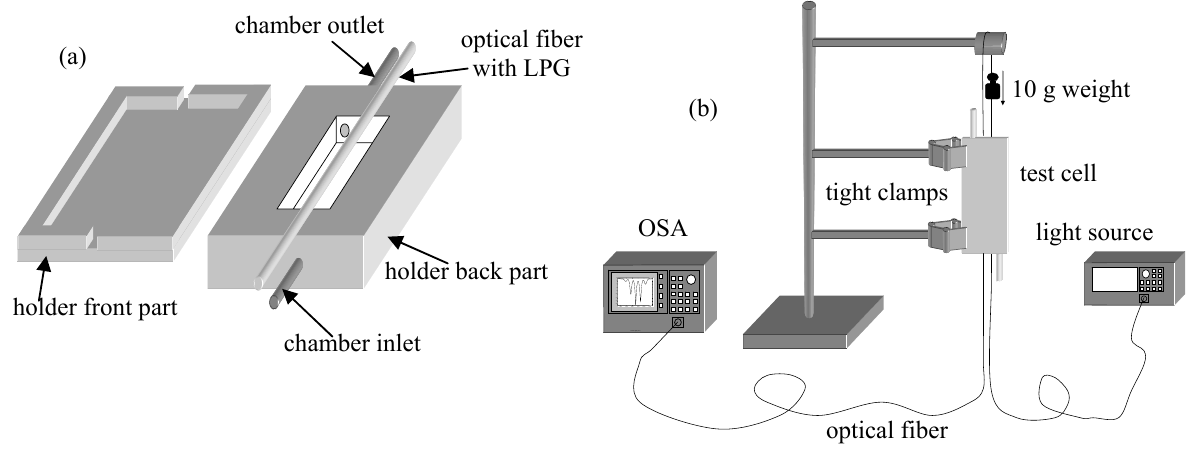
Figure 21. (a) Schematic of the LPG holder for thin film deposition by dip coating and for analyte testing; (b) Schematic of the opto-electronic set-up used for the interrogation of